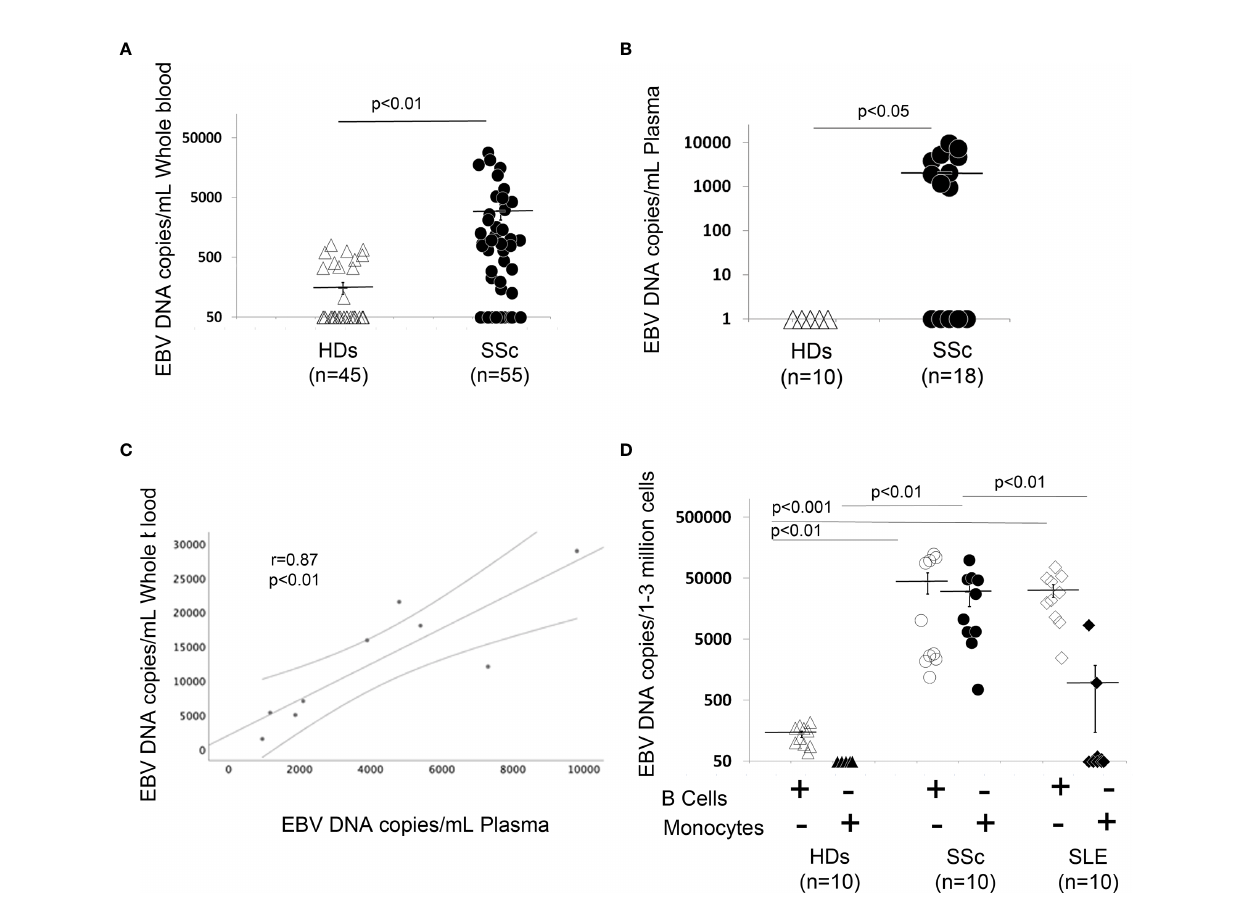
FIGURE 1 | EBV DNA load is increased in blood, plasma, B cells and monocytes from patients with SSc. (A, B) EBV DNA was extracted from whole blood (A) or plasma (B) . (C) SSc patients with high copies of EBV DNA in blood show high copies of EBV in plasma (Spearman r=0.81, p<0.01). (D) EBV DNA was extracted from B cells and monocytes. EBV DNA was quanti fi ed by qPCR. EBV quantitative curve was generated using ABI`s Viral load control (Advanced Biotechnologies, Columbia, MD, USA). qPCR analysis was performed using primers and probe designated to amplify the EBV polymerase BALF5, and measured using SYBR Green chemistry. Shown here are copies of viral DNA calculated by standard curve. All the samples were tested in triplicates. The average of copies number is represented by horizontal line ± SE. p-values calculated using Student T-Test 2